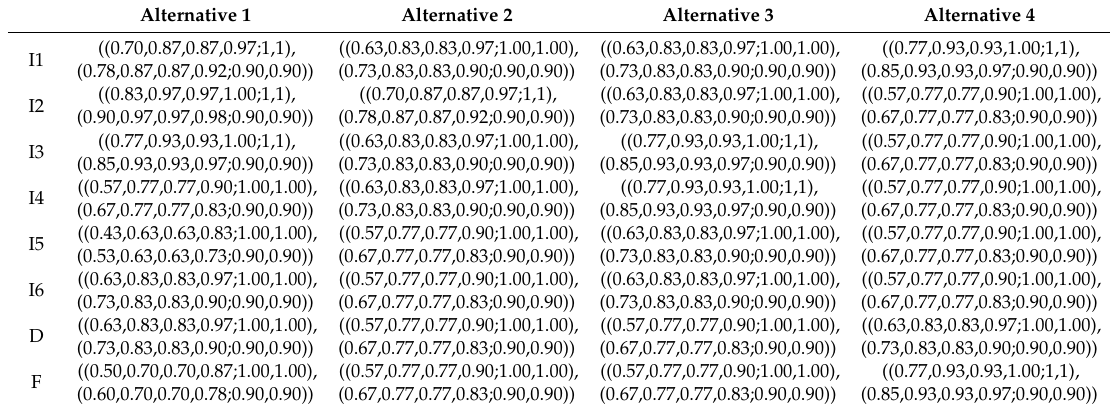
Table A11. Decision matrix.